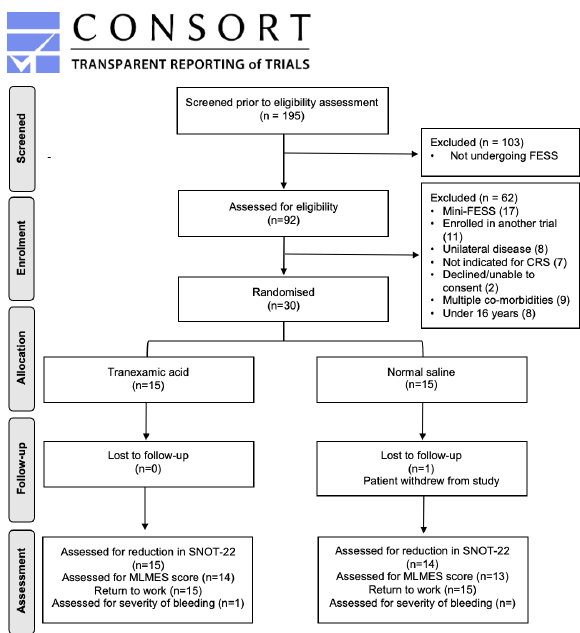
Figure 2. CONSORT 2010 extension to randomised pilot and feasibil- ity trials. FESS = Functional endoscopic sinus surgery: CRS = Chronic Rhînosinusitis; SNOT-22 = 22-item Sinonasal outcome tool; MLMES = Modified Lund-Mackay Post-operative endoscopic